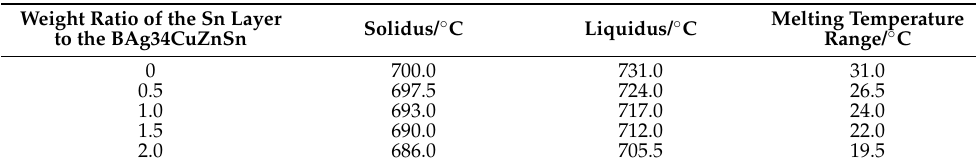
Table 3. Melting characteristics of BAg34CuZnSn brazing filler metals with different contents of the brush-plated Sn layer